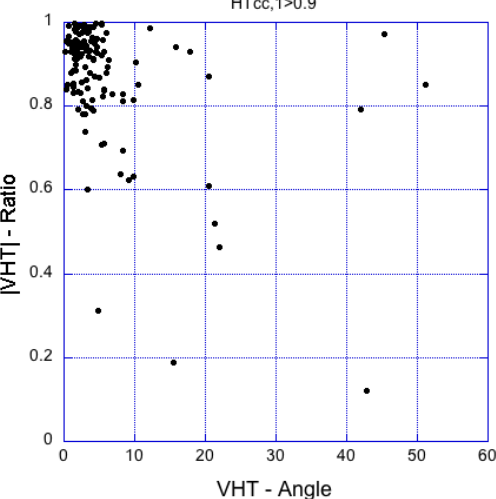
Fig. 8. Scatterplots of the magnitude ratio and the angles between the left and right V HT vectors, for the cases with HT cc , 1 ≥ 0.9.